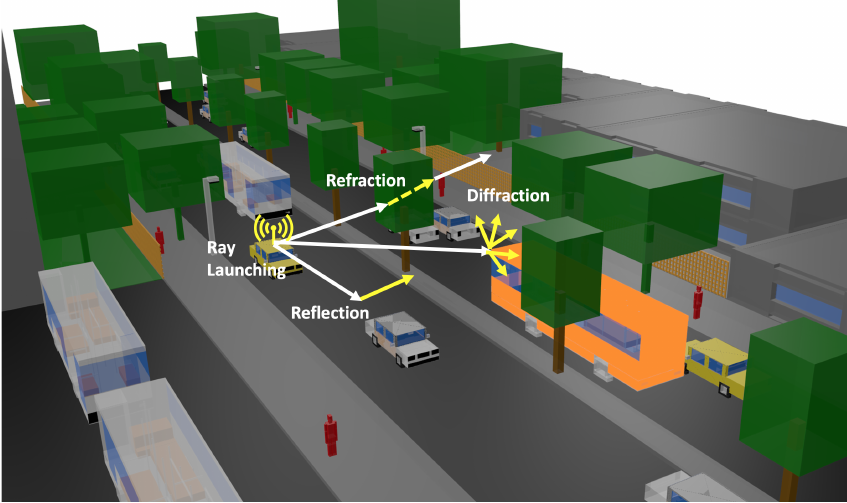
Figure 2. Schematic overview of the operation principle of the 3D-RL